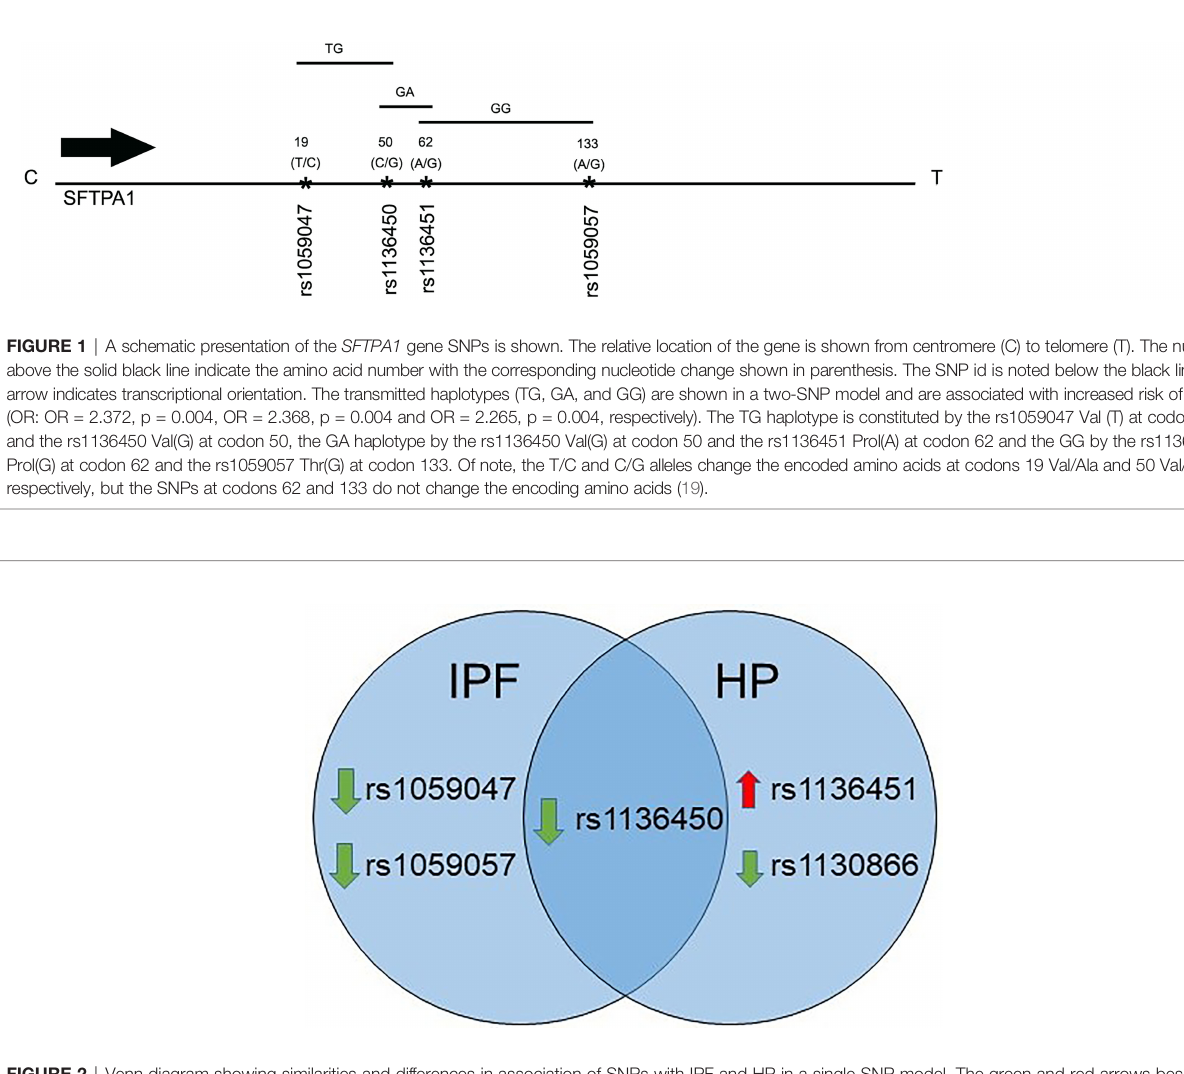
FIGURE 2 | Venn diagram showing similarities and differences in association of SNPs with IPF and HP in a single SNP model. The green and red arrows besides SNPs show association of a given SNP with decreased and increased risk,